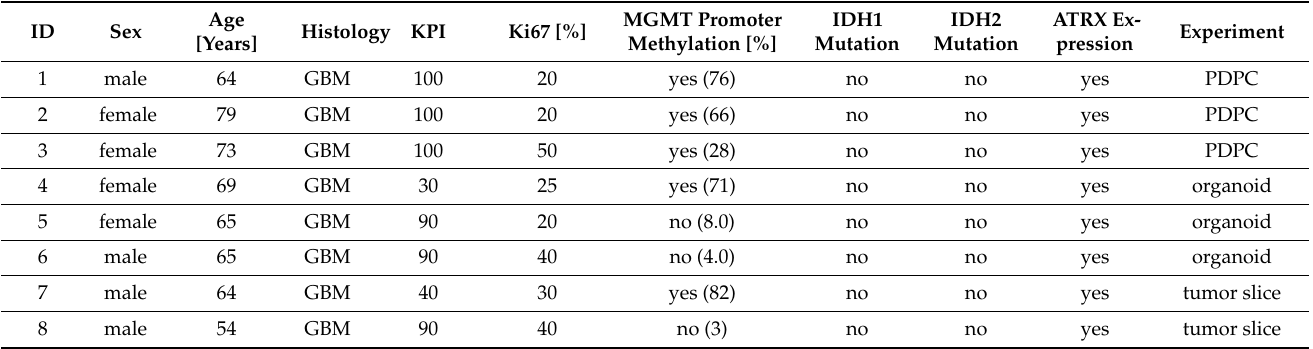
Table 1. Clinical parameters of glioblastoma samples and the models they were utilized